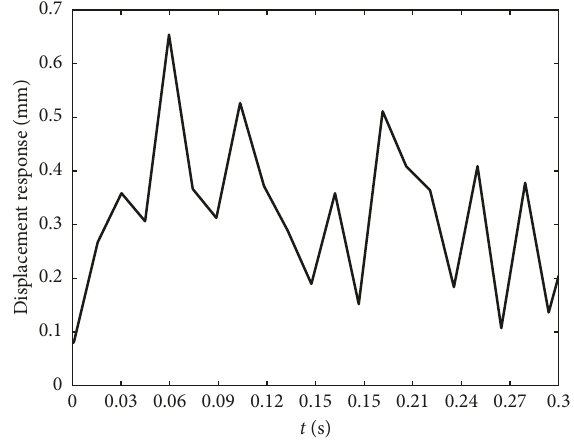
Figure 5: Measured displacement response. Table 2: The experimental conditions for cutting coal